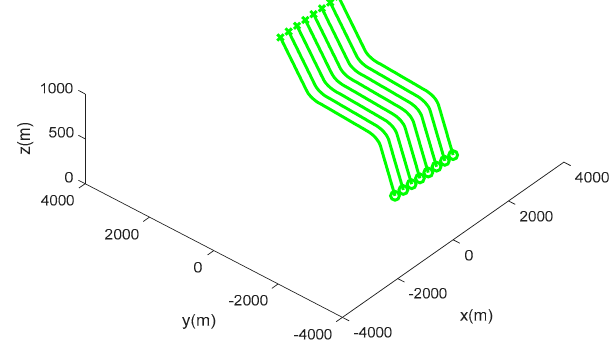
Figure 5. Target trajectories in scenario 2.